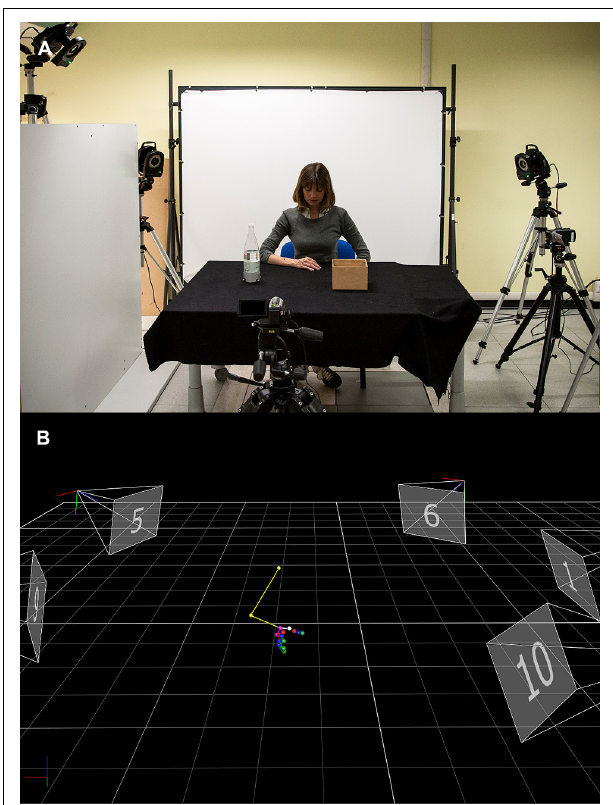
FIGURE 1 |Techniques used to quantify the influence of intention on movement kinematics. (A) Example of experimental set-up employed in action execution studies.The participant sits at a table with his hand resting in a starting position, which is kept constant across participants.The task is to reach and grasp the object (i.e., a bottle) either to lift it or to place it inside a box. An optoelectronic system (Vicon Motion Systems Ltd., UK) equipped with nine infra-red cameras is used to quantify reach-to-grasp movements.This system relies on passive markers (retro-reflective material on a plastic sphere) placed on points of interest over participant’s hand. An infra-red light is transmitted toward the work space area and the rays are reflected back off the markers to a series of “cameras” that record their positions.These positions are then referred to a coordinate system, the origin of which is either in 2-D or 3-D coordinates, i.e., two or three mutually orthogonally axes, each passing through the origin. (B) A computer-generated stick figure representing the position of the markers placed over arm and hand joints during a reach-to-grasp movement toward the bottle. After collecting raw data, it is possible to identify and track the marker’s trajectories almost in real time by means of tracking procedures.